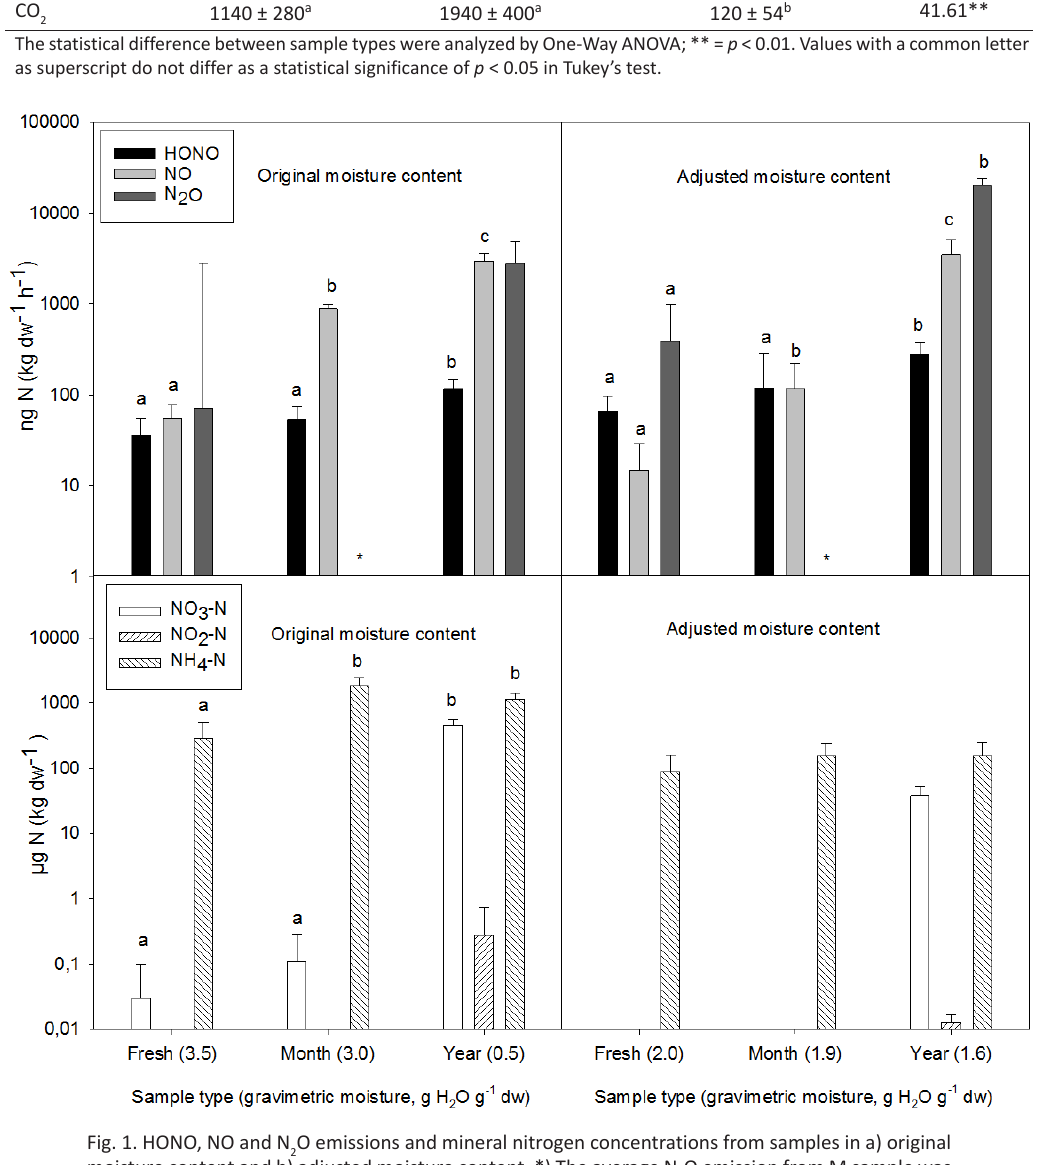
O emission from M sample was 2